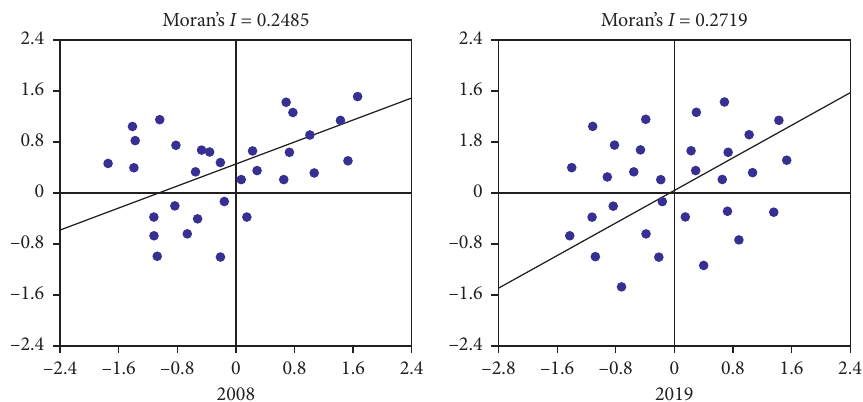
Figure 4: Moran index scatterplot of the ecological environment in 31 provinces of China in 2008 and